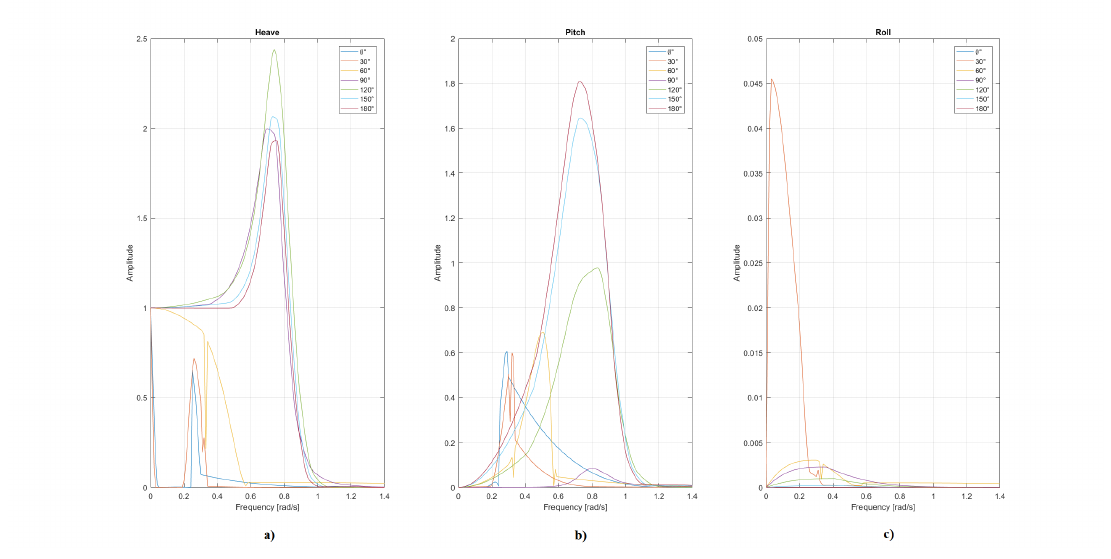
Figure 6. Amplitudes of Response amplitude operator (RAO) for ( a ) heave, ( b ) pitch, and ( c ) roll